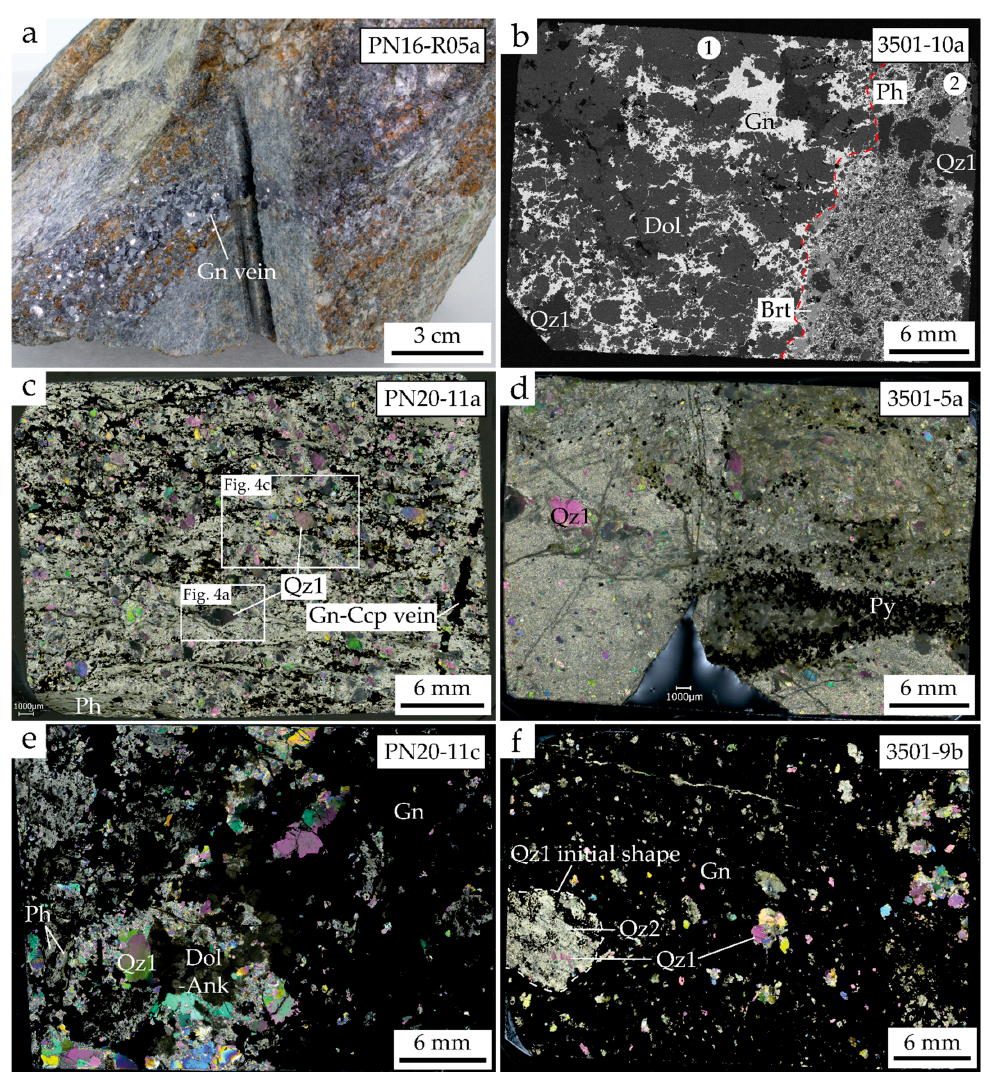
Figure 3. Macroscopic views of rock samples ( a ); BSE thin section image ( b ); thick sections under cross polars ( c – f ) of the various typologies of the Pb-Ag ore. ( a ) Massive galena in a vein crosscutting a phyllitic quartzite from a mining waste of the Peisey-Nancroix mine (PN16-R05a). ( b ) Fractured dolomite filled mainly by massive galena (zone 1) at the contact with fine-grained tetrahedrite–tennantite, galena, pyrite, and gangue (barite, quartz, and phengite) (zone 2) in MP sample (3501-10a). Note the deformed porphyroclasts of quartz with some chlorite in 3501-10. Images of thick sections from: ( c ) Thick section of quartzite with disseminated ore aligned in the schistosity (PN20-11a); ( d ) Quartzite with pyrite-carbonates veins (3501-5a); ( e ) Quartzite with massive ore (PN20-11b); ( f ) Massive sulfides with quartz porphyroclasts (3501-9b). Brt: barite; Ccp: chalcopyrite; Chl: chlorite; Dol: dolomite; Dol-Ank: dolomite–ankerite; Gn: galena; Py: pyrite; Qz: quartz (after Whitney and Evans [70]).